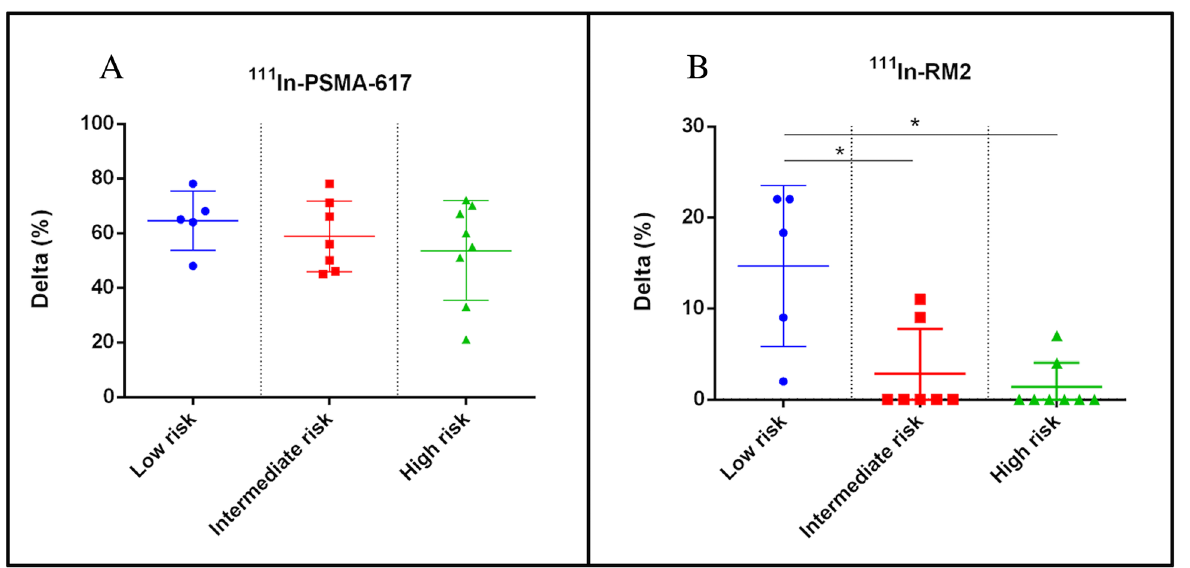
Fig. 3 a 111 In-RM2 binding in low-, intermediate-, and high-risk prostate cancer samples. 111 In-RM2 binding is significantly higher in low metastatic risk compared to intermediate- or high-risk samples. b 111 In-PSMA-617 binding in low-, intermediate-, and high-risk prostate cancer samples. Binding of 111 In-PSMA-617 is high in all samples with no significant differences between groups. Non-parametric one-way ANOVA (Kruskal-Wallis test). p < 0.05 was considered